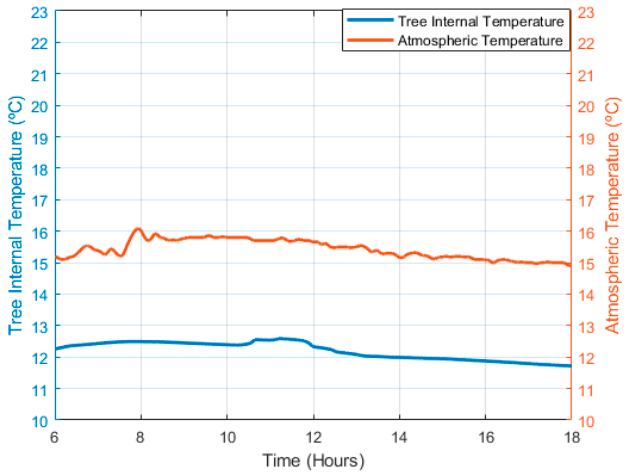
Figure 7. Internal and external tree temperature (°C) evolution over time—Experimental test 1.